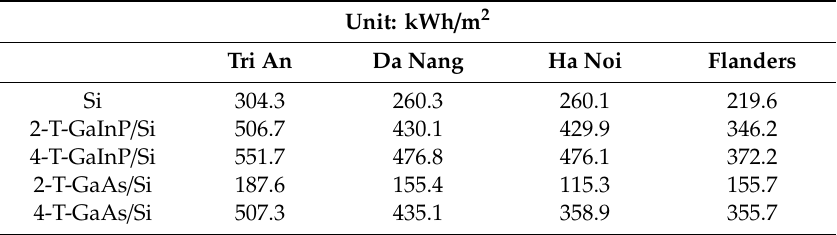
Table 5. Annual yield of Si-based tandem solar cells (kWh / m 2 ) for di ff erent